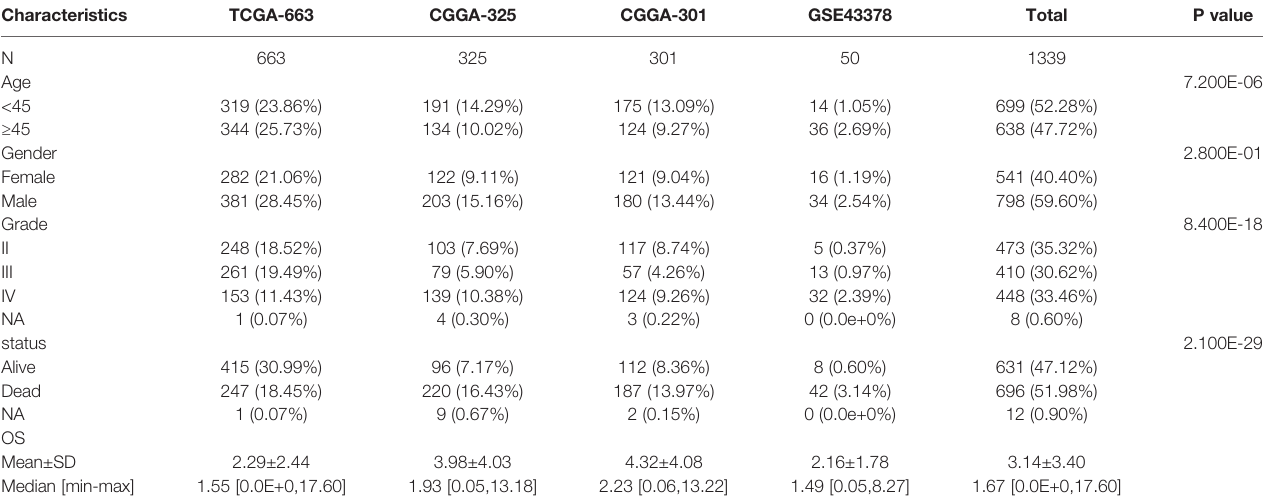
TABLE 1 | The baseline clinical characteristics of the glioma samples.